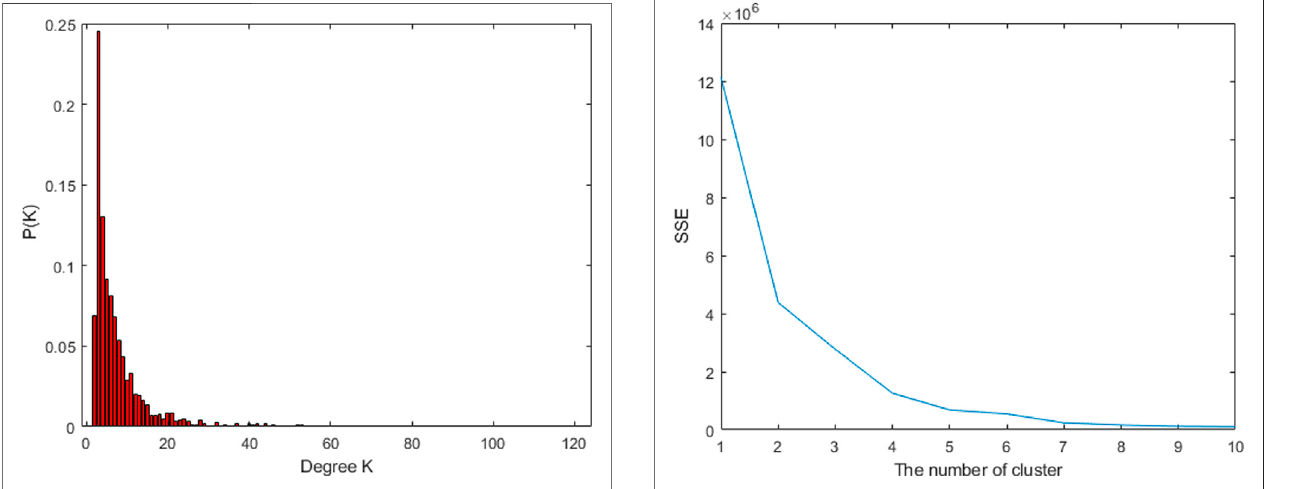
FIGURE 3 | Power distribution of visibility network in Beijing. FIGURE 4 | Elbow method result for